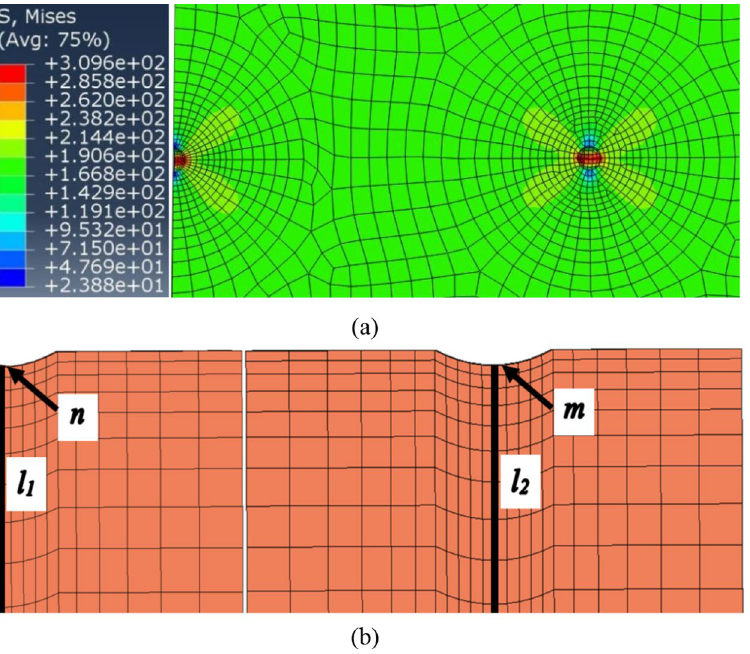
Figure 7. Computational block element stress nephogram: ( a ) Global stress nephogram; ( b ) Symmetrical line of micro-notches m and n